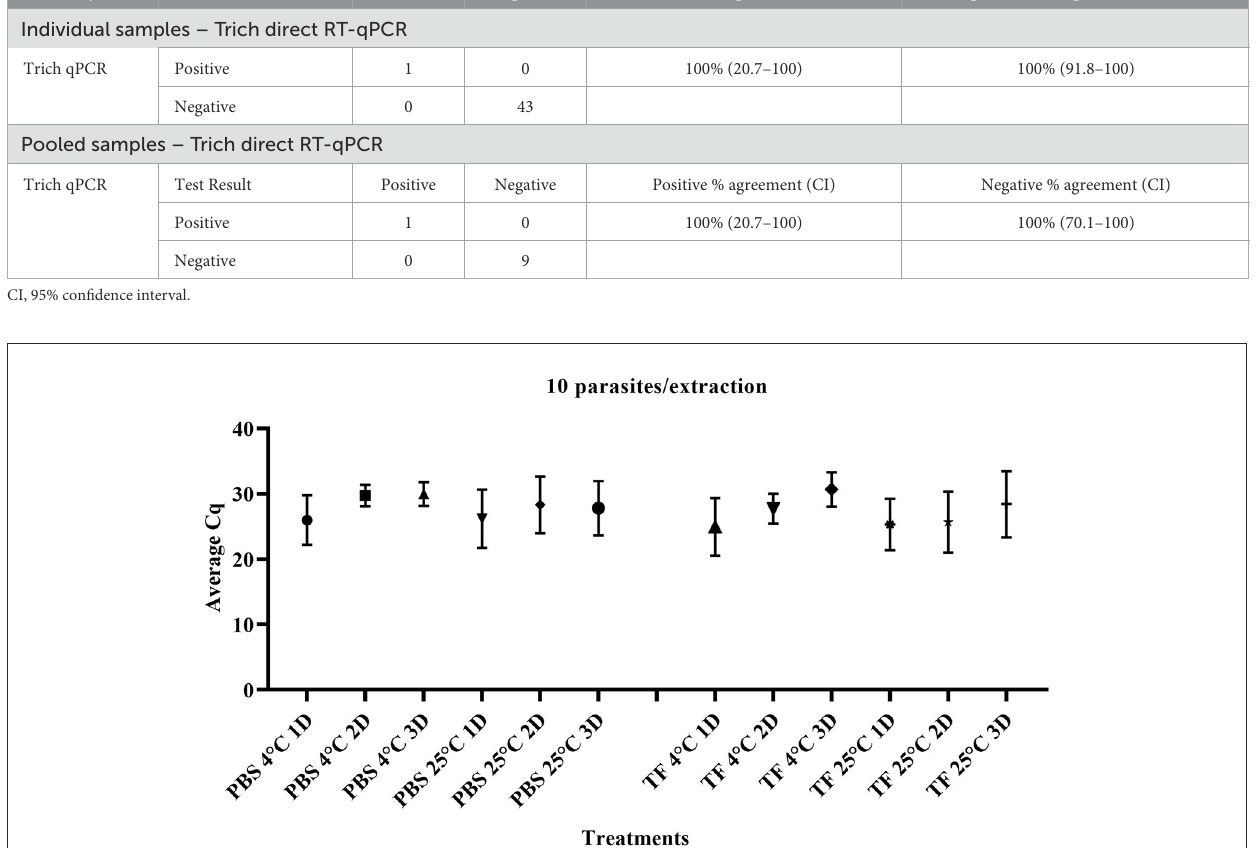
FIGURE3 Quantification cycle (Cq) of T. foetus RNA in PBS or TF media at 1, 2, and 3 days post-incubation at 4 ◦ C and 25 ◦ C at 10 parasites/extraction.